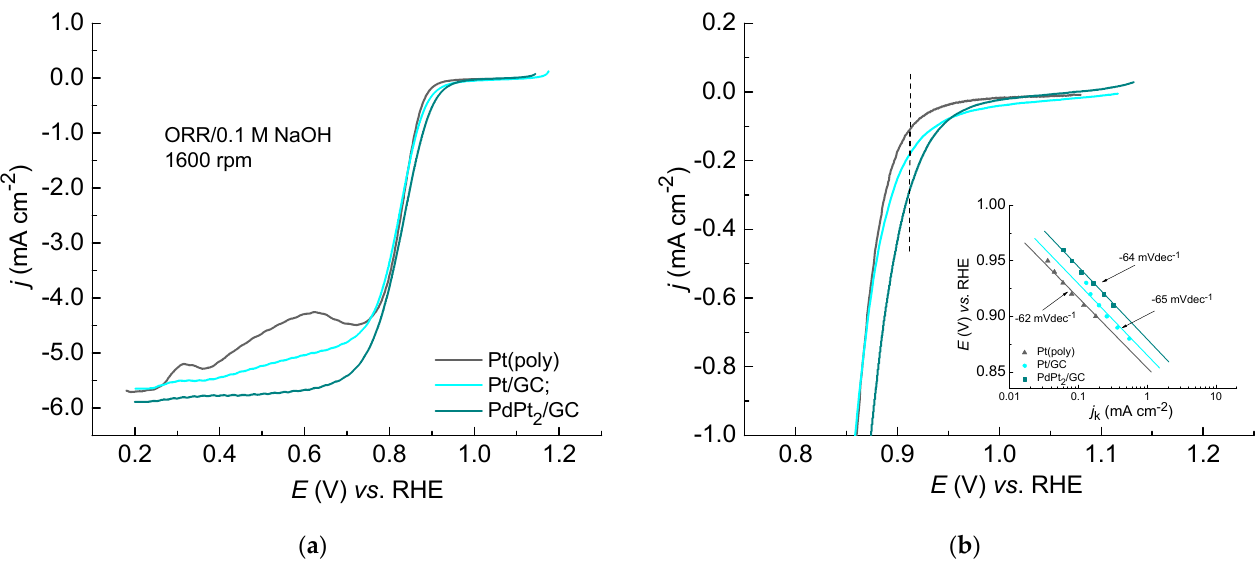
Figure 10. Comparison of the polarization curves for ORR on PdPt 2 /GC, Pt/GC, and Pt(poly) electrodes in 0.1 M NaOH: ( a ) Current densities are given with respect to the geometric area of the GC electrode; ( b ) Current densities in the activation control region are given with respect to the ECSA; insert shows corresponding Tafel plots. The ORR initial potentials (for j k = 0) for Pt/GC and PdPt 2 /GC are 1.09 V and 1.12 V, exceeding the initial potential for polycrystalline Pt (1.00 V vs. RHE) for 90 mV and 120 mV, respectively.